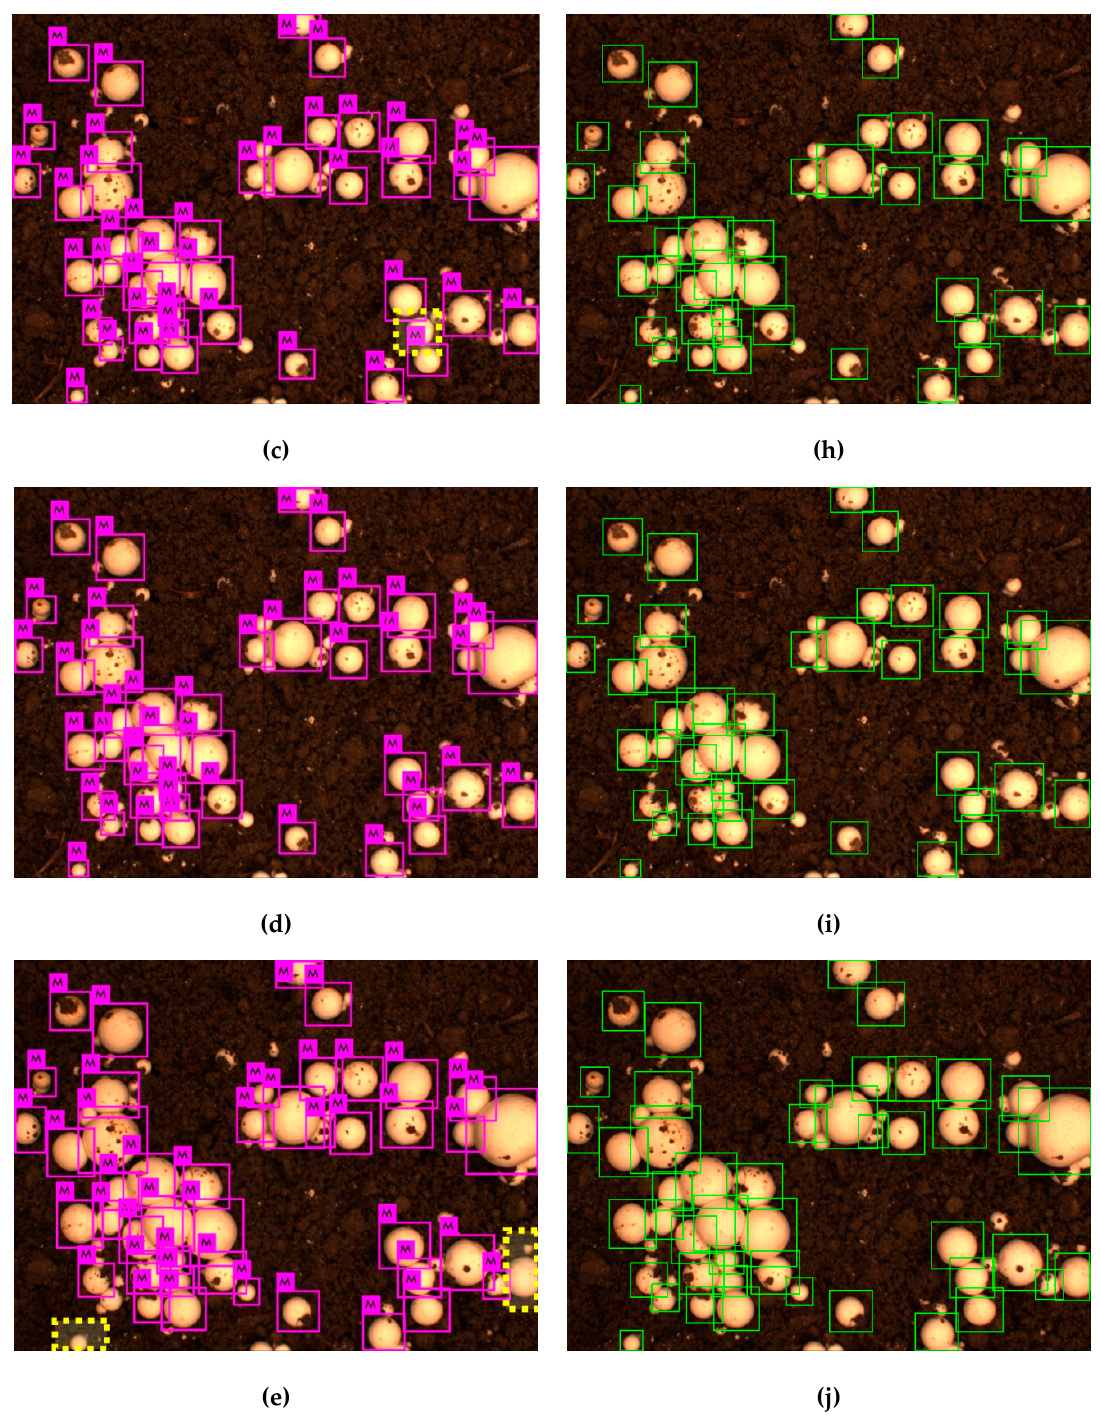
Figure 8. The experiments of positioning correction. The original positioning image at ( a ) 0 h, ( b ) 1 h, ( c ) 2 h, ( d ) 3 h, and ( e ) 13 h. ( f ) The initial positioning, ( g ) the first positioning correction, ( h ) the second positioning correction, ( i ) the third positioning correction, and ( j ) the 13th positioning correction.